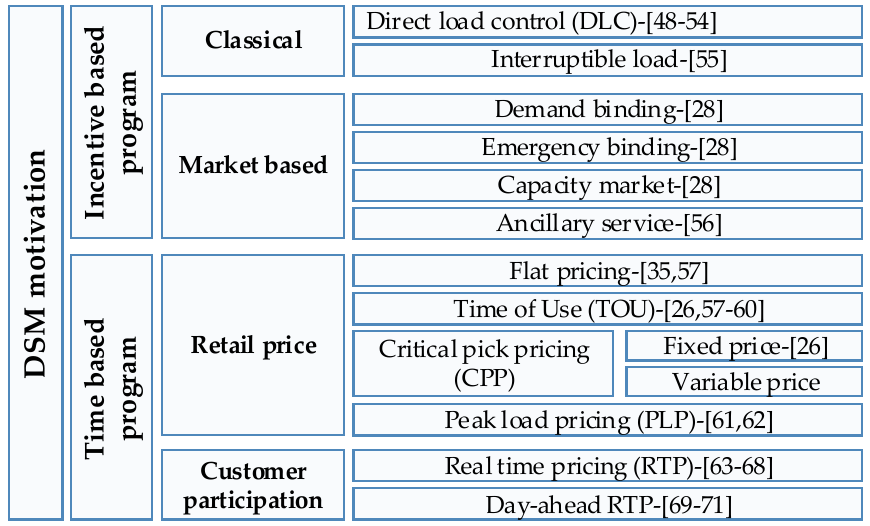
Figure 2. Category of DSM schemes based on motivation methods.